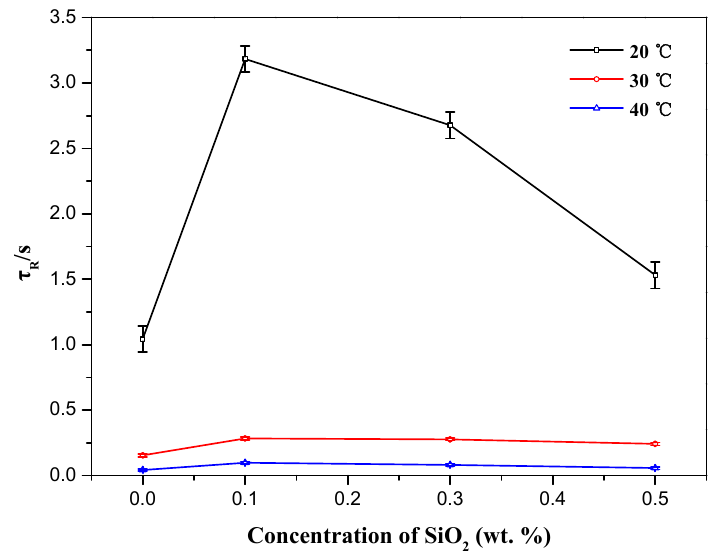
Figure 5. Relaxation time ( τ R ) of NEWMS with different nanoparticle concentrations at 20, 30, and 40 °C.